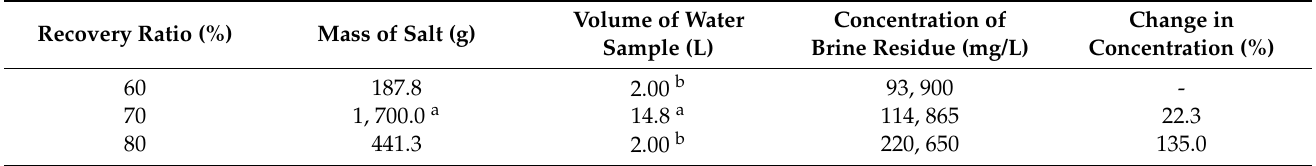
Table 5. Comparison of the brine residue concentrations at different recovery